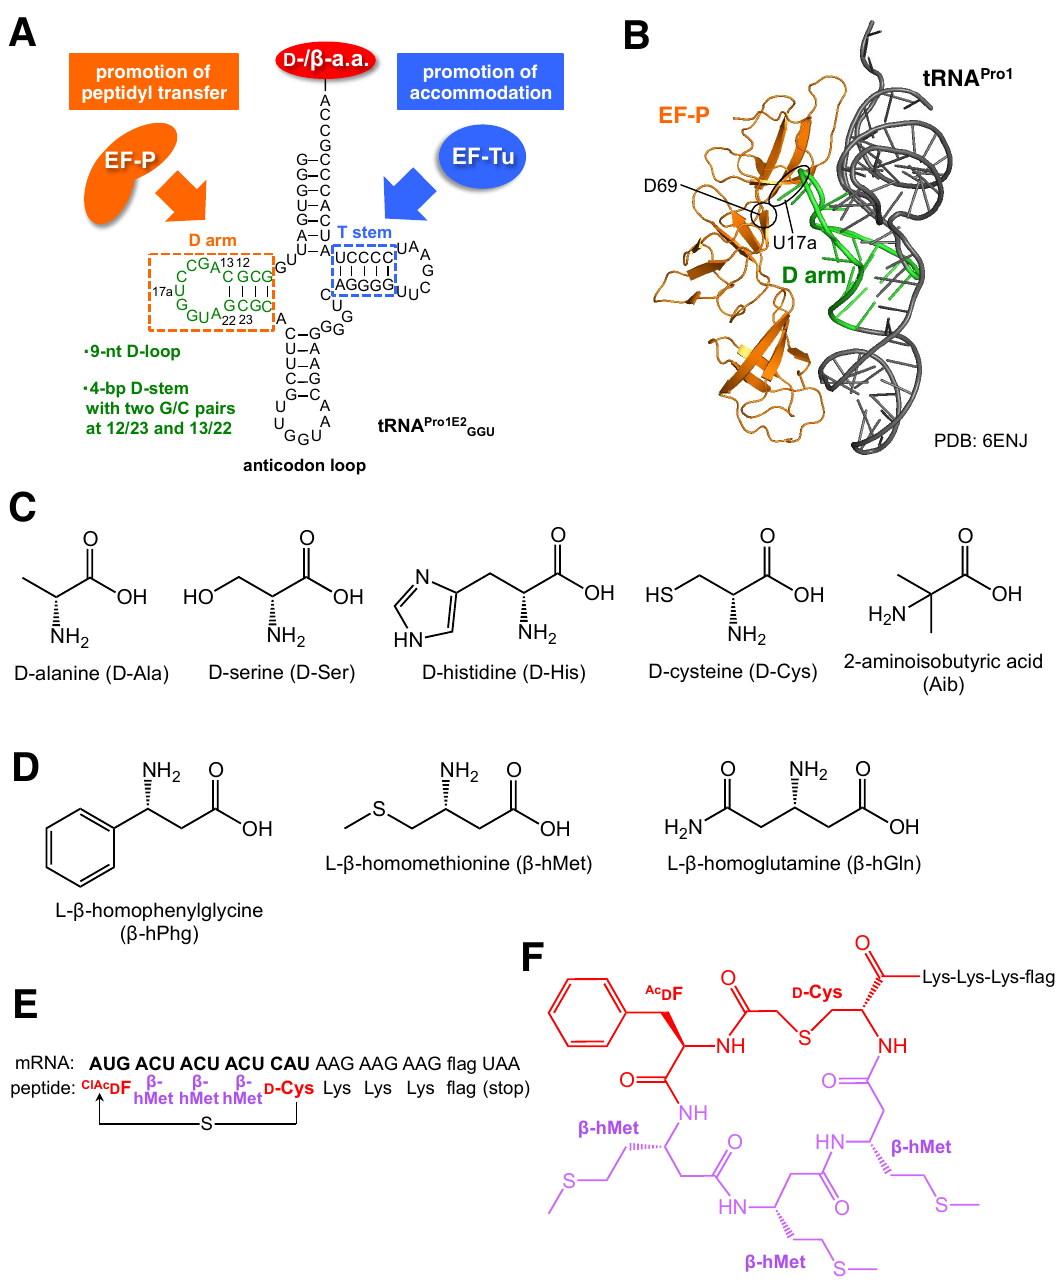
Figure 4. Incorporation of consecutive D - or β -amino acids by an engineered tRNA. ( A ) Secondary structure of tRNA Pro1E2 GGU . The D-arm and T-stem motifs for tight EF-P and EF-Tu binding are indicated in orange and blue, respectively. The D-arm motif, consisting of a 9-nt D-loop closed by a 4-bp D-stem and containing two G/C pairs at positions 12/23 and 13/22, is shown. ( B ) Structure of Escherichia coli EF-P bound to P-site peptidyl-tRNA Pro1 . Asp69 of EF-P and U17a of the tRNA D-loop are within hydrogen-bonding distance. Structural information is taken from PDB: 6ENJ. Structures of D - ( C ) and β -amino acids ( D ) tested for consecutive incorporation using tRNA Pro1E2 in combination with EF-P. ( E ) Sequence of a model peptide containing multiple D - and β -amino acids, and its template mRNA. The sulfhydryl group of the side chain of D -Cys spontaneously reacts with the chloroacetyl group of the N-terminal ClAc D F to give a nonreducible thioether bond and macrocyclizes the peptide. ( F ) Structure of the model macrocyclic peptide, whose sequence is shown in